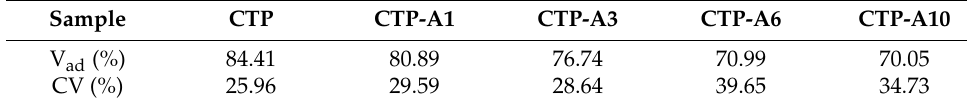
Table 2. The characteristic properties of catalytic air oxidized CTP.